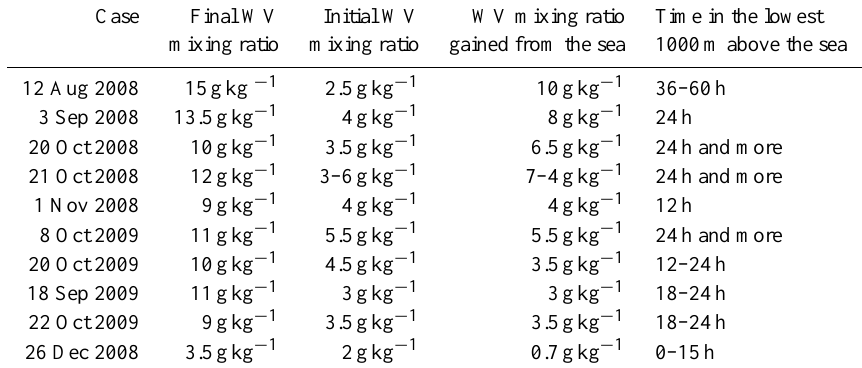
Table 2. Approximate water vapour mixing ratios of the parcels along their pathway.